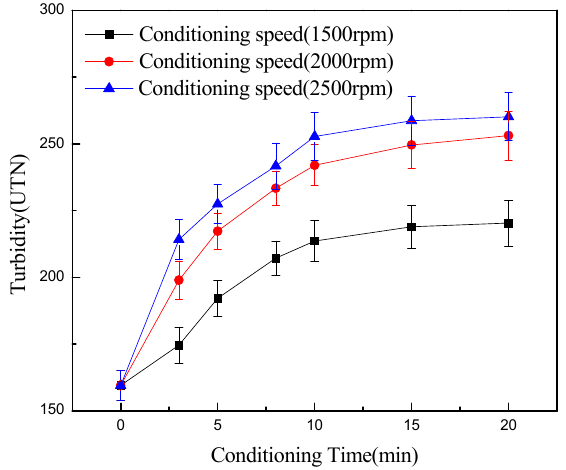
Figure 5. Turbidity of mixed minerals (pyrrhotite and chlorite were mixed by 10:1) as a function of conditioning speed and time of pH = 9.0 ± 0.2.